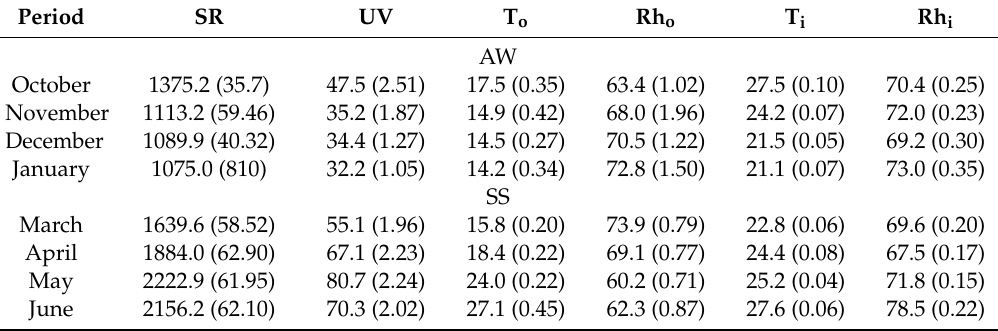
Table 1. Daylight hourly values (standard errors in brackets) of solar radiation (SR, kJ m − 2 ) and ultraviolet radiation (UV, kJ m − 2 ); air temperature (T o ◦ C, outside greenhouse and T i ◦ C, inside greenhouse) and relative air humidity (Rh o %, outside greenhouse and Rh i %, inside greenhouse), in two cropping periods (autumn-winter; AW; spring-summer;